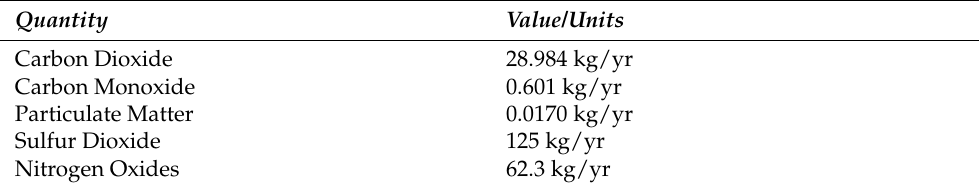
Table 7. Emission profile for system